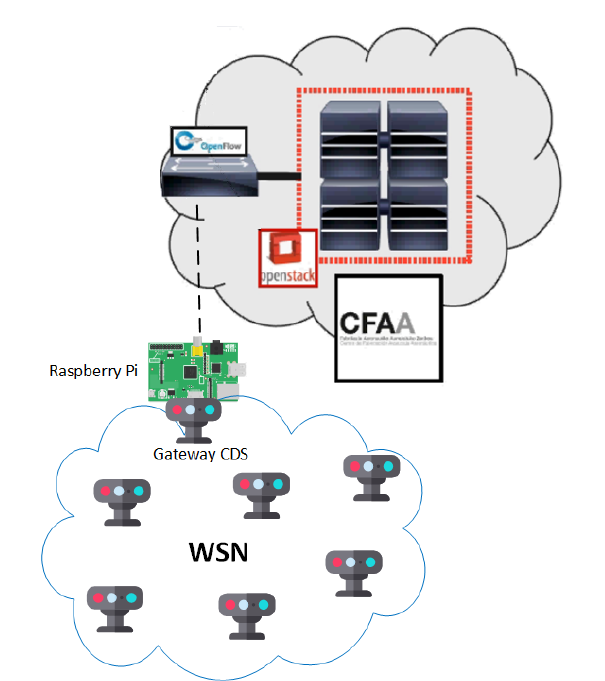
Figure 7. Integration of the Wireless Sensor Network (WSN) in the